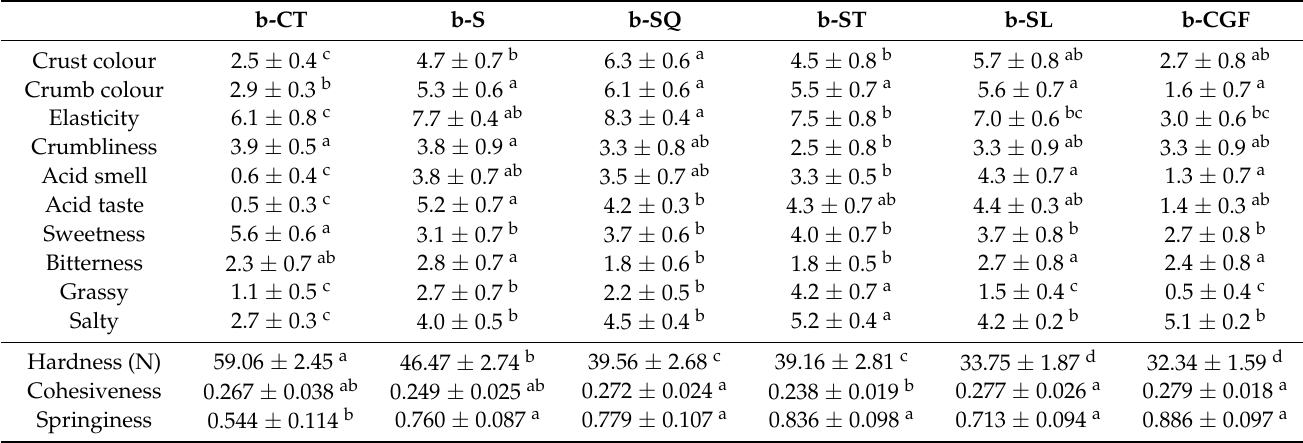
Table 5. Sensory and texture profile analysis of